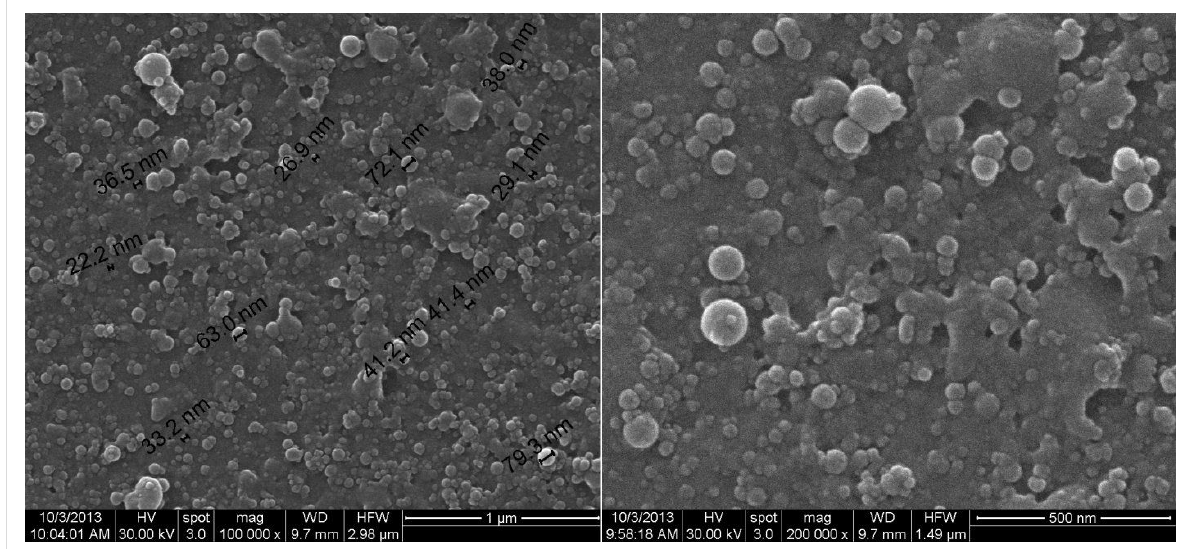
Figure 5: SEM images of nanosphere thin coatings prepared by MAPLE at different magnifications.